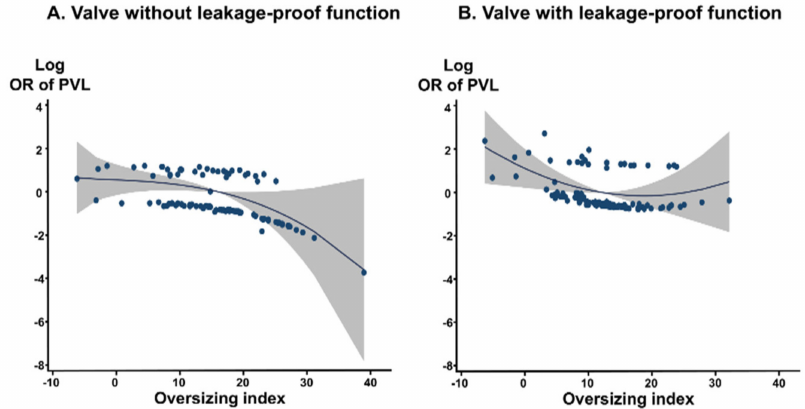
Figure 4. Continuous relation between oversizing index and risk of PVL calculated by fractional polynomial regression. Gray shading indicates 95% confidence interval around the flat line. The OR was adjusted for the calcium amount. ( A ) valve with leakage-proof function; ( B ) valve with leakage-proof function. OR, odds ratio; PVL, paravalvular